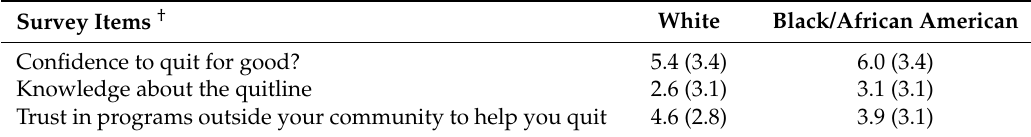
Table 4. The significant differences among Black and White current/former tobacco users.